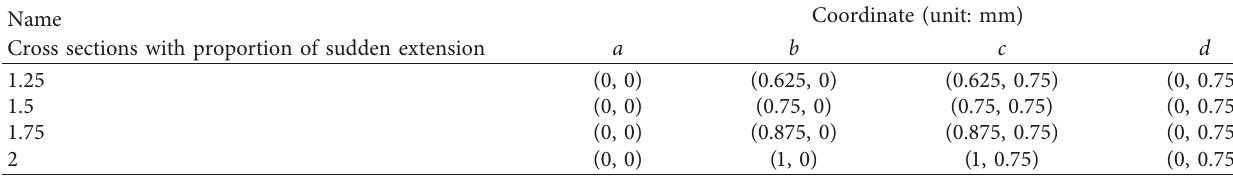
Table 1: Structure size of sections with different proportions of sudden